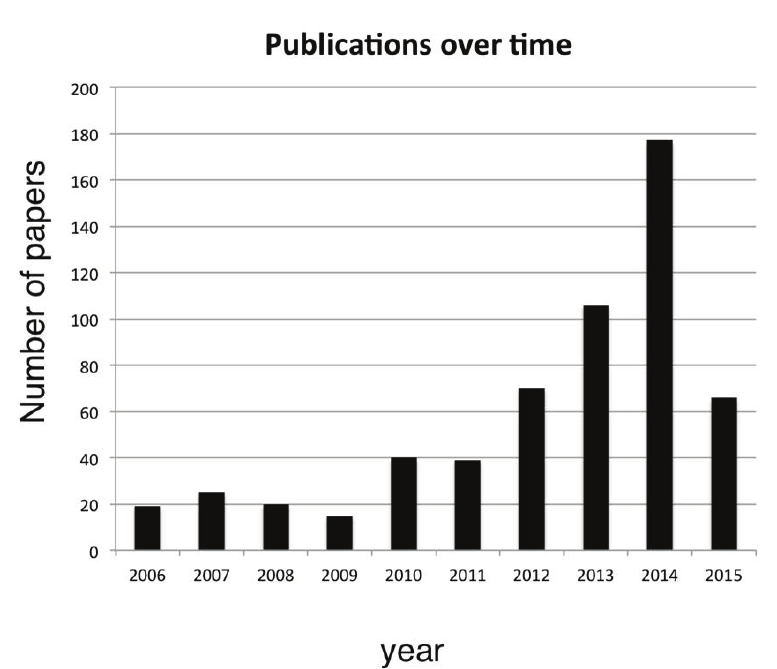
Figure 1. Bar graph illustrating the number of publications per year from 2007 to 2015 obtained with the PubMed search “(intellectual disability OR mental retardation) AND (next-generation sequencing OR exome